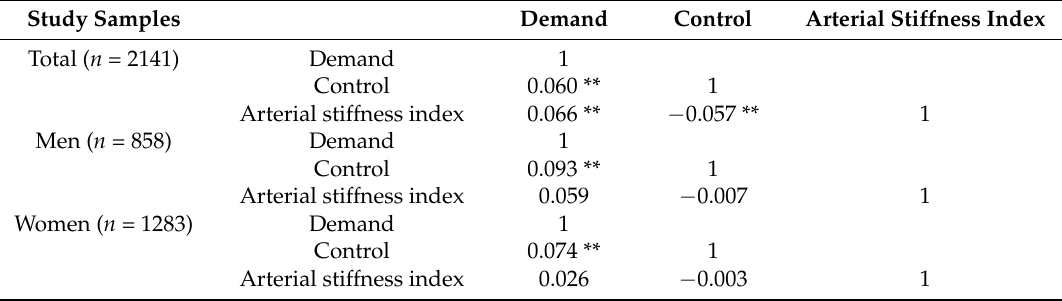
Table 2. Correlations among demand, control and arterial stiffness index (correlation coefficients).